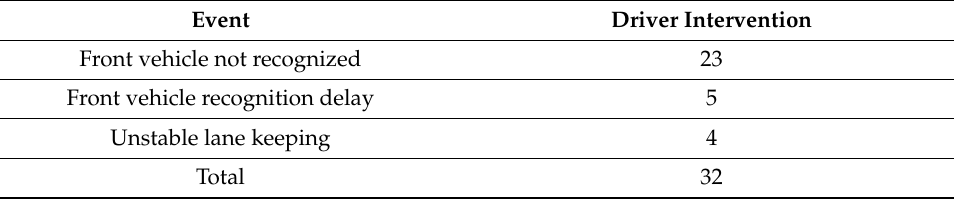
Table 13. Number of events—driver intervened during the autonomous driving functions operation.